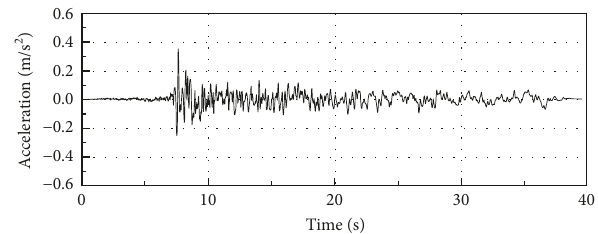
Figure 9: Earthquake acceleration time-history curve of intensity 7 frequently of Alaska (longitudinal